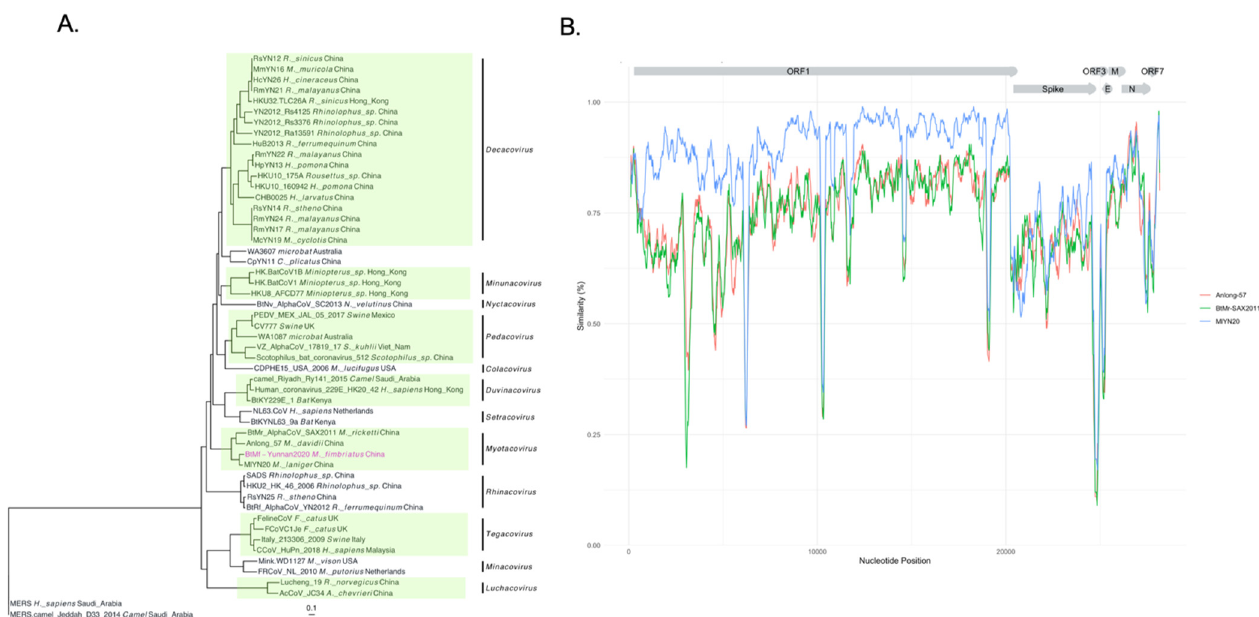
Figure 7. Phylogenetics and similarity of the BtMf-Yunnan 2020 genome. ( A ) A phylogenetic tree was inferred from the alignment of the nucleotide sequences of the alphacoronavirus genomes (23,544 bp). The inference was based on a GTR + I + G model. Alphacoronavirus subgenera are indicated. ( B ) Similarity profile of myotacovirus sequences to the BtMf-Yunnan2021 genome.